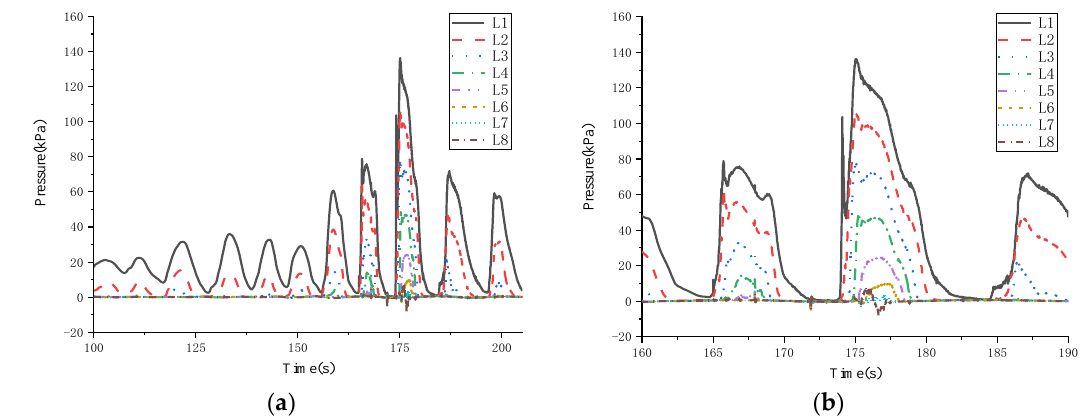
Figure 13. Pressure time history curve of L1 – L8 monitoring point on front surface of column. ( a ) Global graphics. ( b ) Detail graphics.